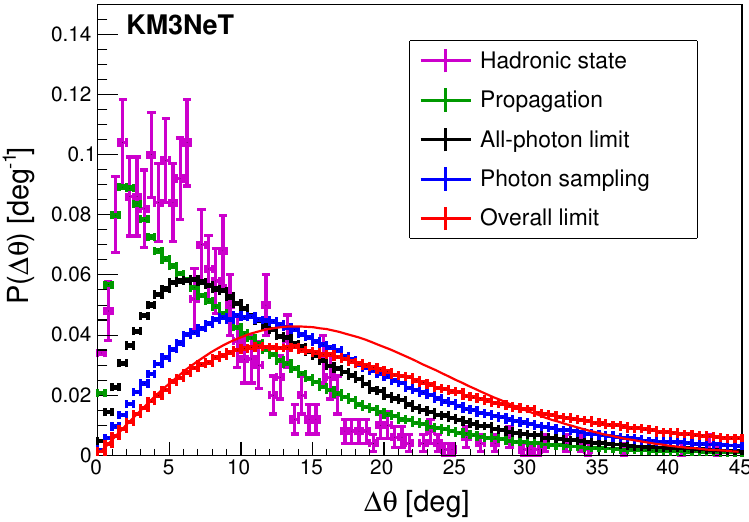
Figure 7 . Distribution of direction errors (cid:1) (cid:18) for E h = 5 GeV, showing histograms from 1000 simulations over each of 1000 interactions. The three di(cid:11)erent sources of variation (hadronic state, propagation, and photon sampling) and their combined e(cid:11)ects for all-photon and overall limits are shown in points, with statistical error bars. A (cid:12)t (red line) to the overall limit using the radial distribution function of a 2D-Gaussian is shown to illustrate its non-Gaussianity.